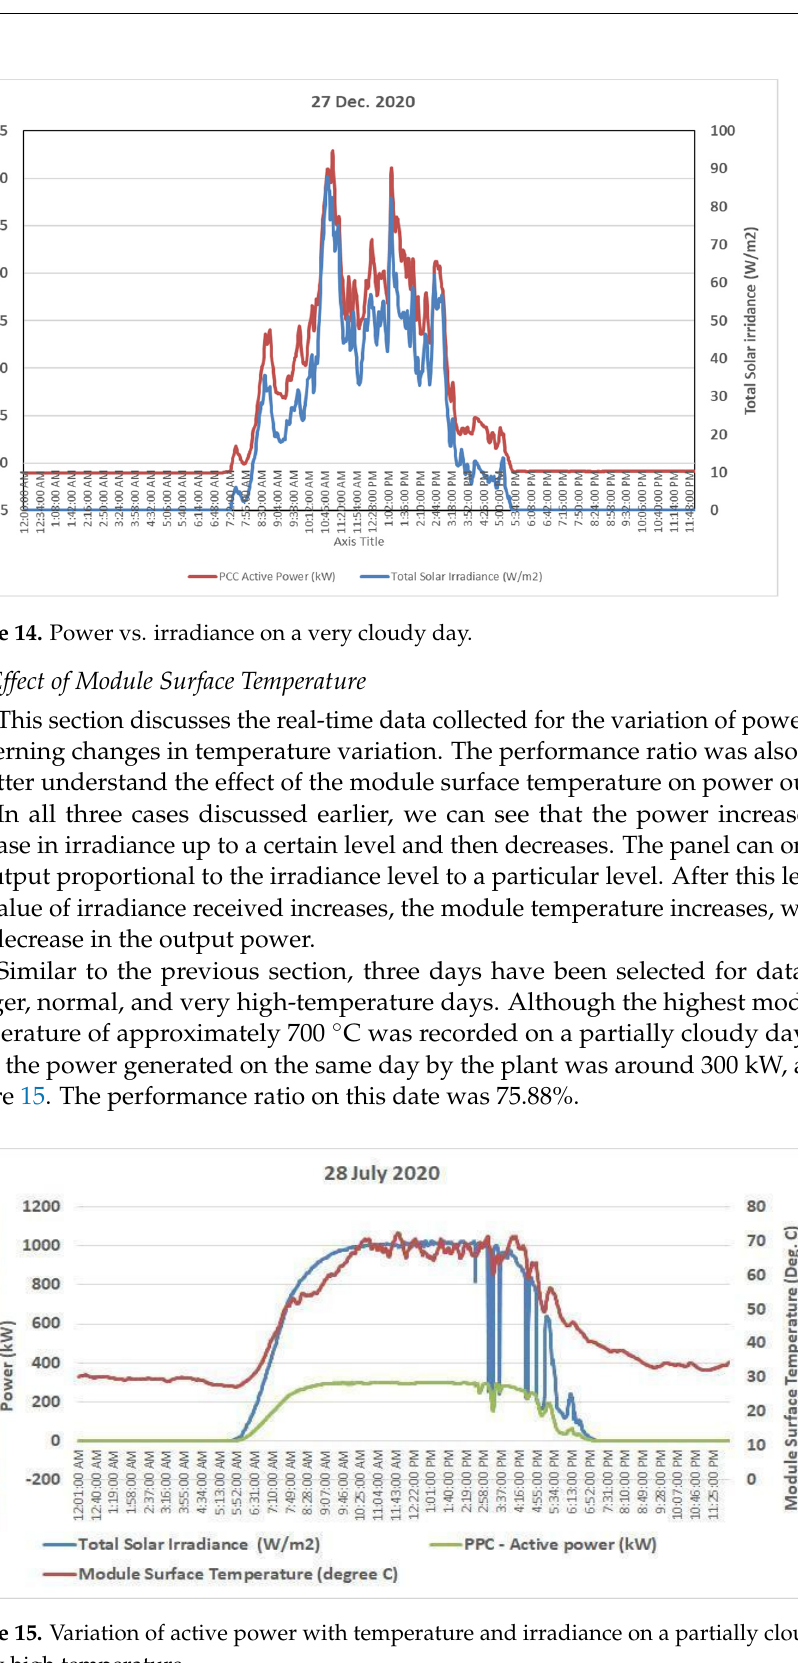
Figure 16. Variation of active power with temperature and irradiance on a day with moderate tem ‐ perature. Finally, a day with the lowest module surface temperature was compared to the pre ‐ vious two cases. The maximum module surface temperature recorded on 25 January was around 230 °C. The module surface temperature was reduced, and the effect can be seen in power generation in Figure 17. A fluctuation in power generation due to changing tem ‐ perature is visible here. The performance ratio (see Table 4) increases with high irradiance, and low temperatures are proven to be productive again, as the performance ratio calcu ‐ lated on this day is 88.3%. To validate the results, module surface temperatures were re ‐ recorded on the same dates in 2021, i.e., 25 January, 5 April, and 28 July 2021.